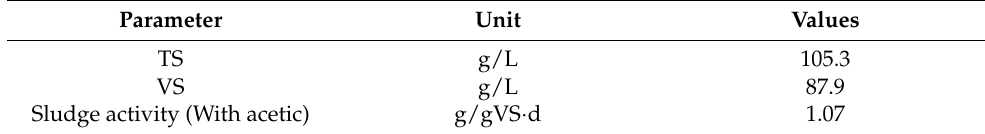
Table 3. Granular sludge properties.